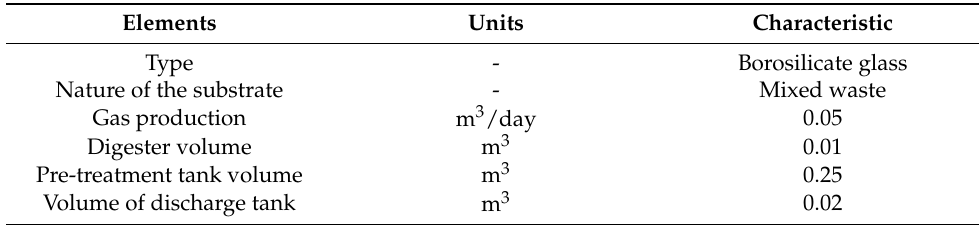
Table 1. Characteristics of the biodigester.